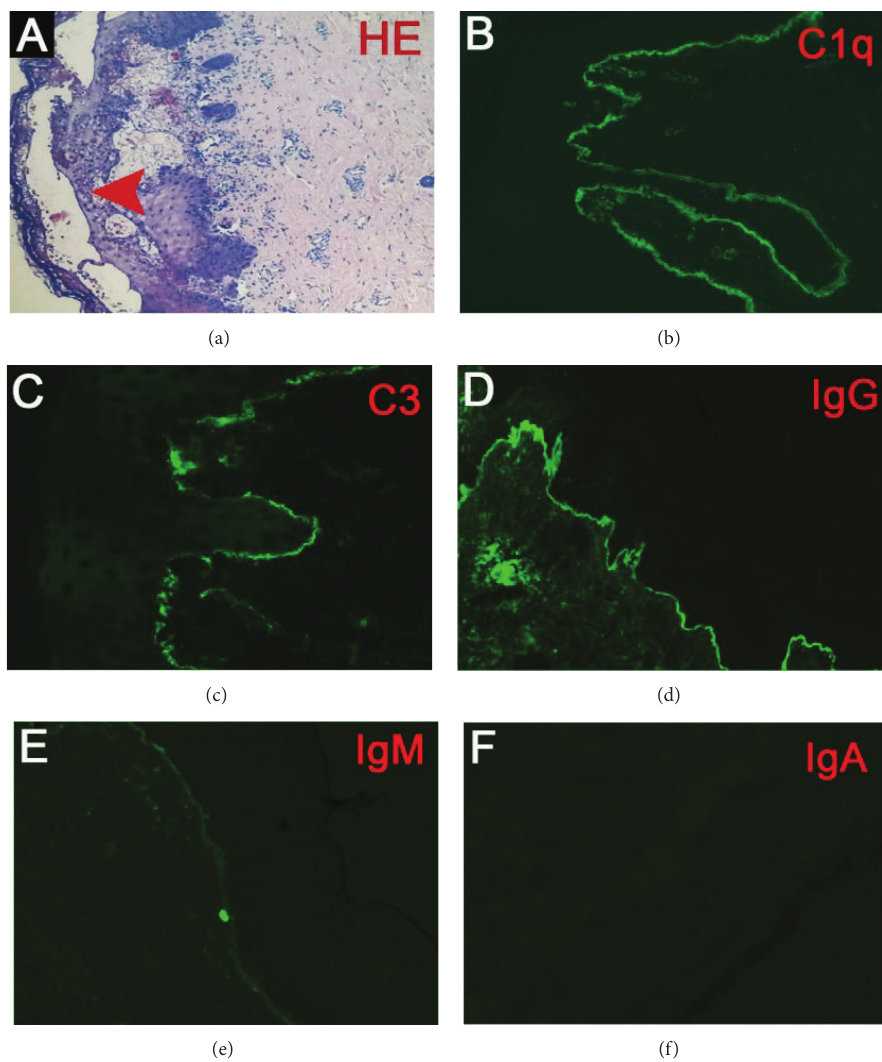
Figure 2: Histopathology of the skin lesion. (a) Histopathologic examination of the skin biopsy specimen showed a subepidermal blister (arrow indicated) with abundant neutrophils infiltration and only occasional eosinophils (H&E stain, 100x). (b) Direct immunofluorescence examination showed linear, granular deposition of C1q (b), C3 (c), and IgG (d) at the dermoepidermal junction (400x); less IgM and IgA were